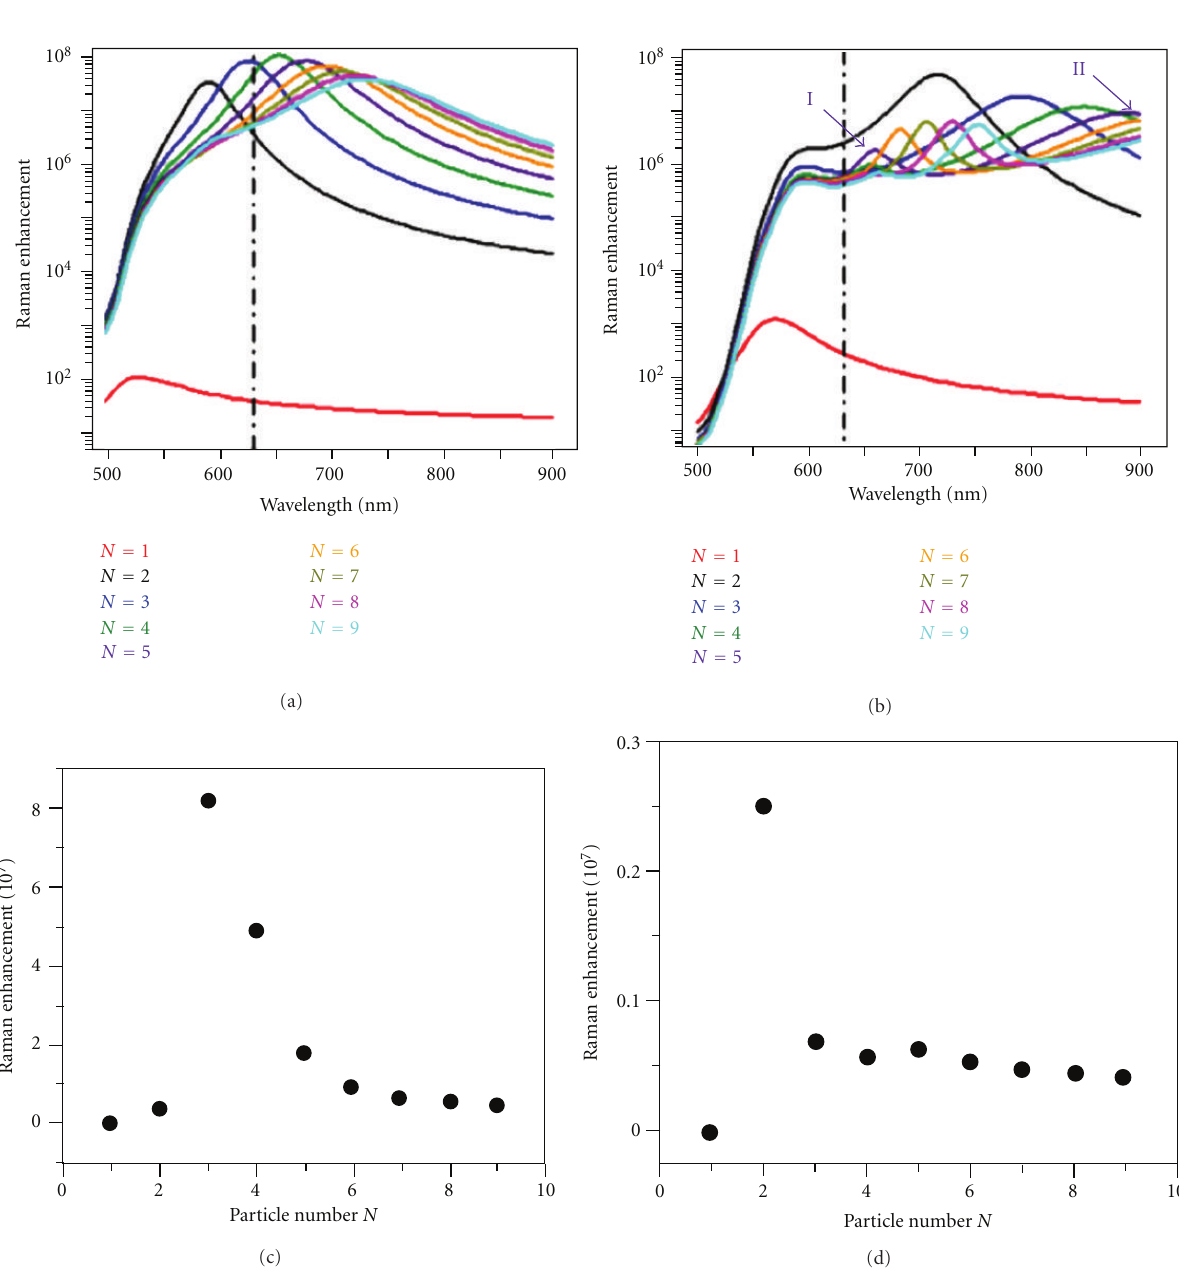
Figure 1: Calculated SERS EFs for Au nanoparticle chains using generalized Mie theory. The EF spectra have been calculated for chains ranging 1–9 nanoparticles in length with excitation source parallel to the long axis of the chain for an interparticle gap of 1 nm and n e ff = 1 . 0 (a) and an interparticle gap of 1.5nm and n e ff = 1 . 5 (b). The EF for the 632.8 nm excitation source for (a) and (b) are shown, respectively, in (c) and (d). Angular momentum contributions up to the 37th order were included in the GMT calculations. The integral was taken at a distance of 0.5 nm from the particle surface for (a) and 0.75nm from the particle surface for (b). The two enhancement peaks for the N = 5 chain are identified as II and I, respectively, in